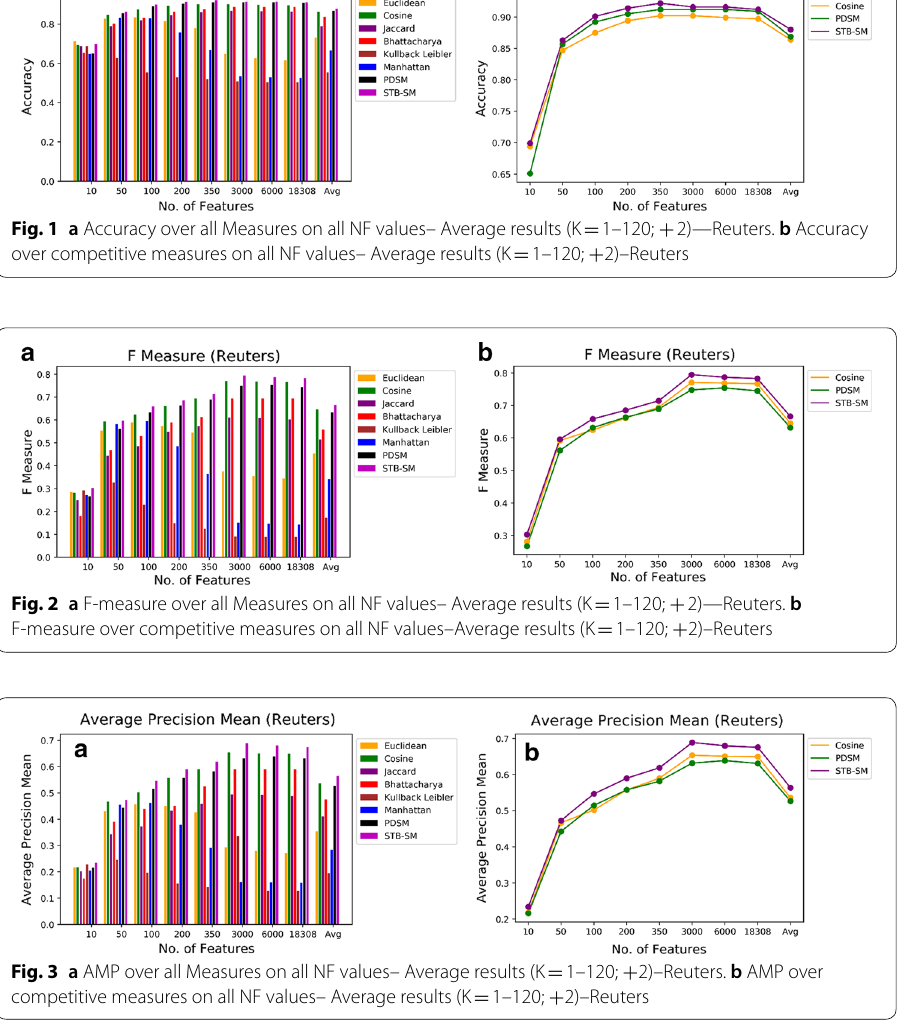
Fig. 3 a AMP over all Measures on all NF values– Average results (K competitive measures on all NF values– Average results (K